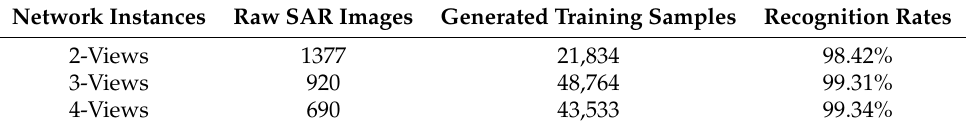
Table 4. Recognition performances of network instances from different